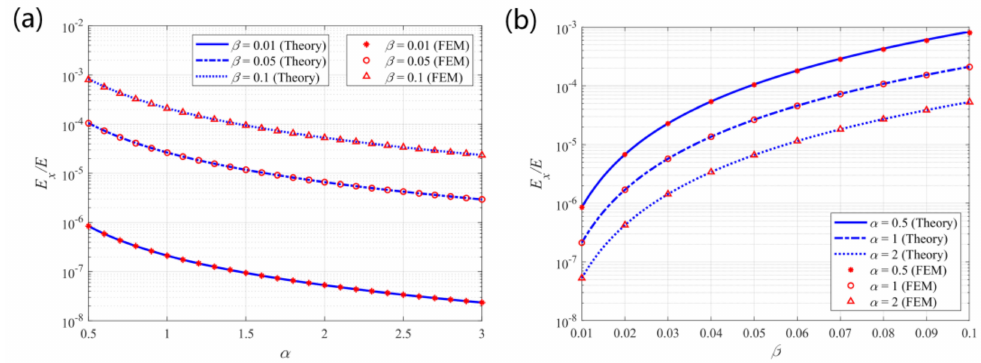
Figure 7. Theoretical predictions and finite element results for the effective elastic modulus E x /E vs. ( a ) α and ( b ) β .